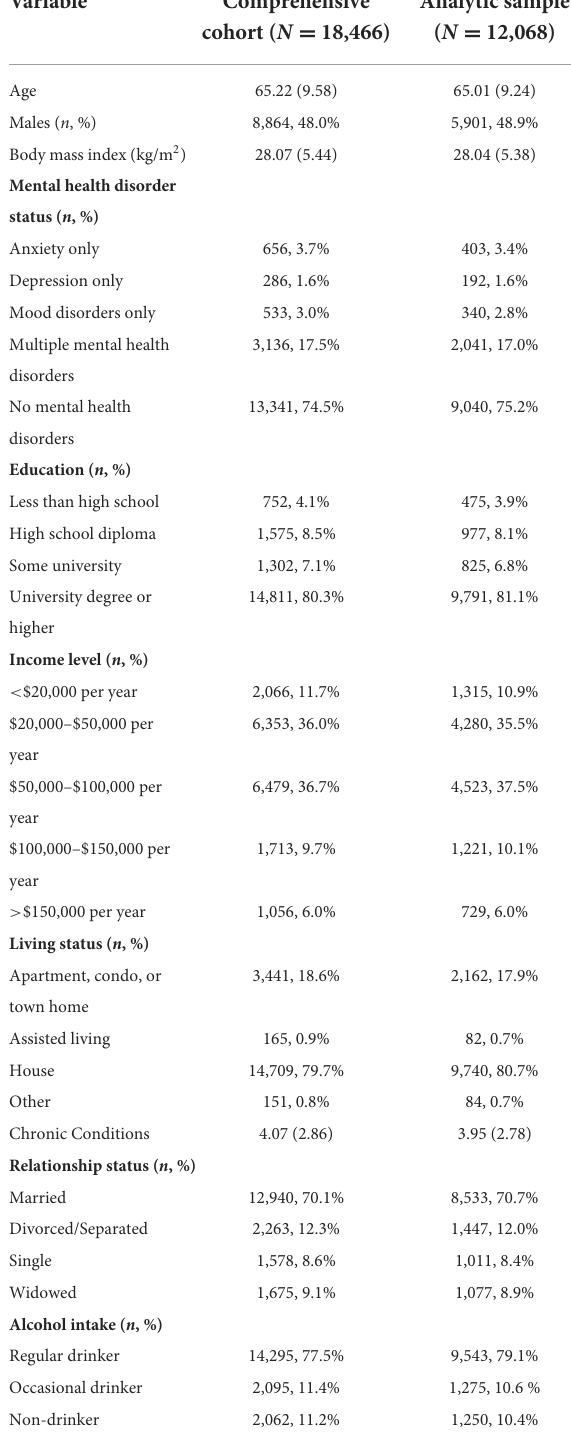
TABLE 1 Participant characteristics at first follow-up (2015–2018) for participants (1) in the Comprehensive Cohort with data at